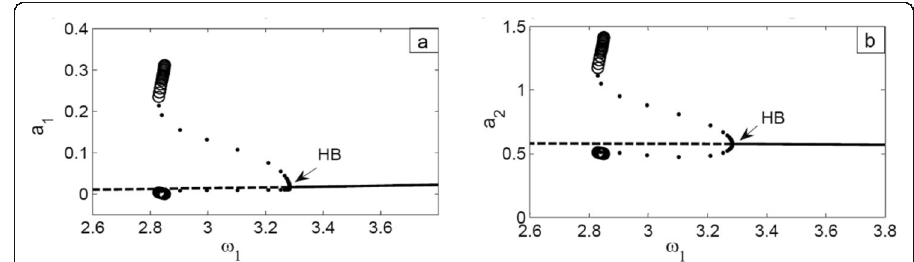
Fig. 15 Bifurcation diagram of natural frequency ω 1 as the bifurcation parameter